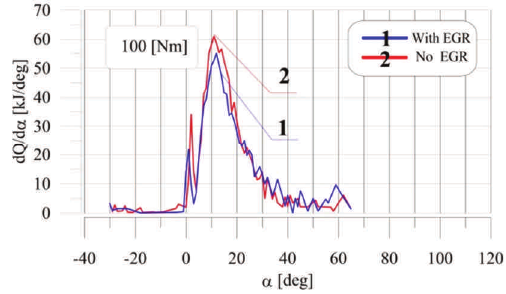
Fig. 15. Influence of the engine crank angle on the rate of heat release inside cylinder for engine operating with/without EGR at torque 100 Nm